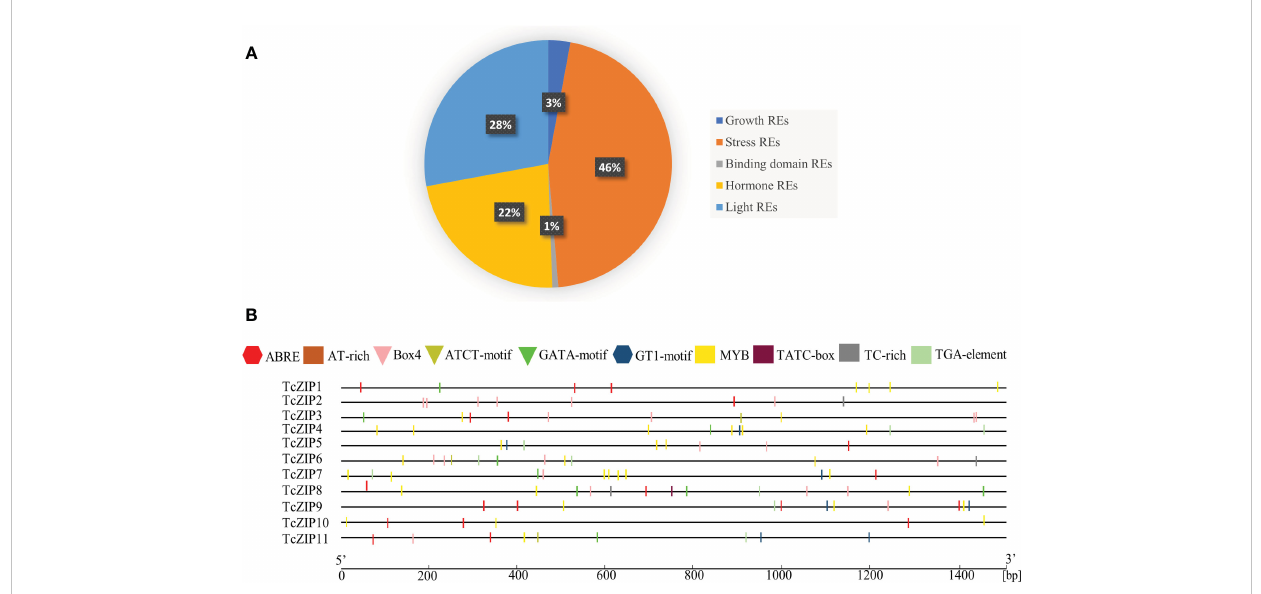
FIGURE 4 Analysis of TcZIP promoter region. (A) Cis-regulatory elements in TcZIP genes promoter regions. Represents the extent of various types of regulatory elements based on function, such as light, hormone, growth, stress and binding domain, excluding the TATA box, CAAT box and (B) Location of cis-regulatory elements in the 1.5 kb 5 ’ upstream region of each TcZIP gene involved in the stress